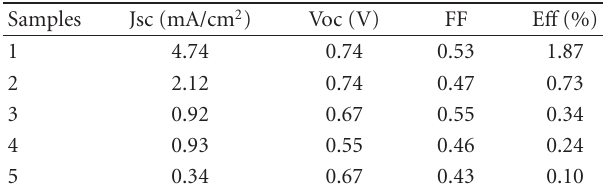
Table 1: Photovoltaic performance of DSSC based on ZnO/TiO 2 composite